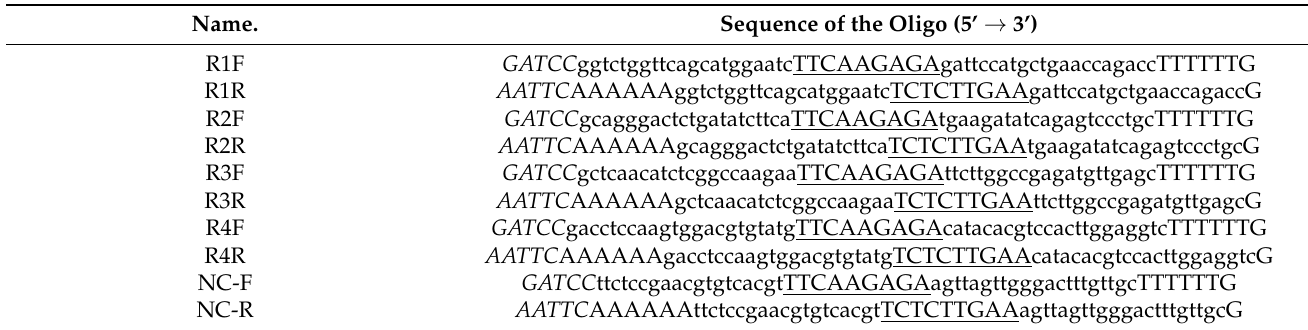
Table 1. Primer sequence of pig FUT3 shRNAs.